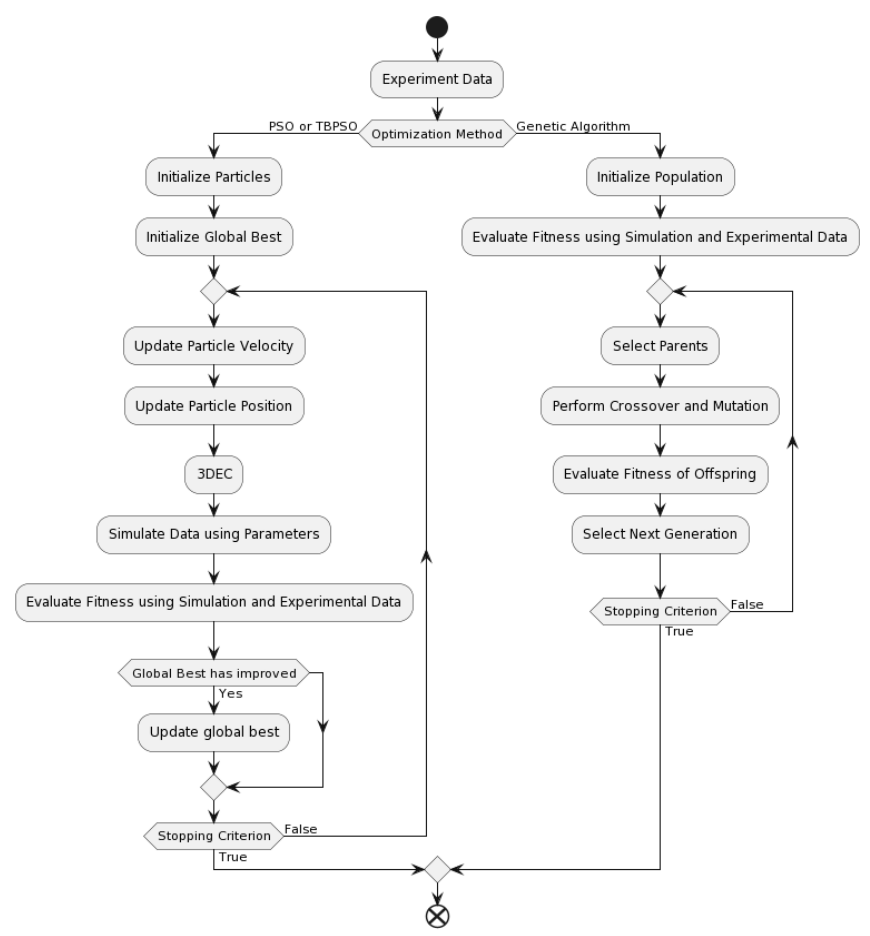
Figure 13. Workflow of the calibration process.